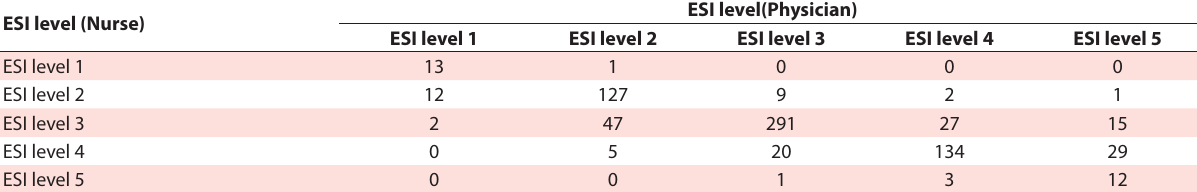
Table 1. Comparison of nurse’s triage and physician’s re-triage ESI level (Nurse)